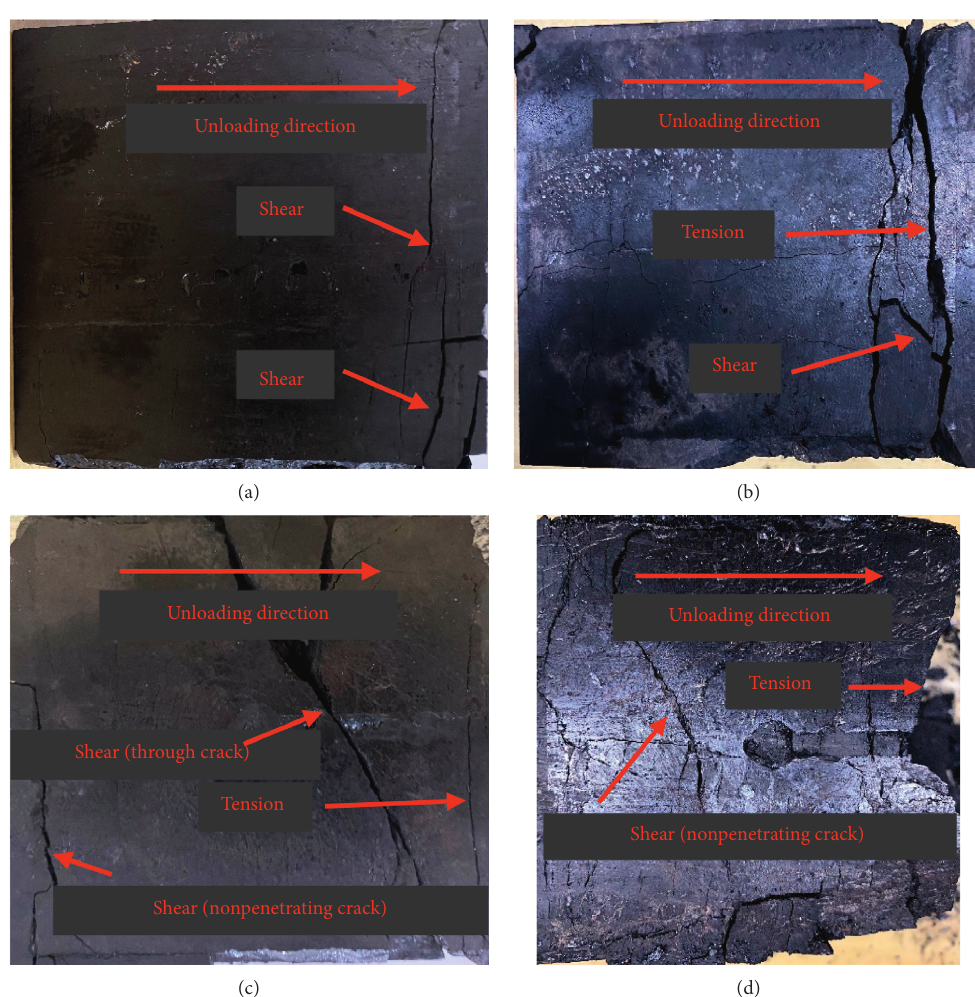
Figure 3: Failure section of coal in true triaxial unloading test. (a) Intermediate principal stress is 3MPa. (b) Intermediate principal stress is 6MPa. (c) Intermediate principal stress is 9MPa. (d) Intermediate principal stress is